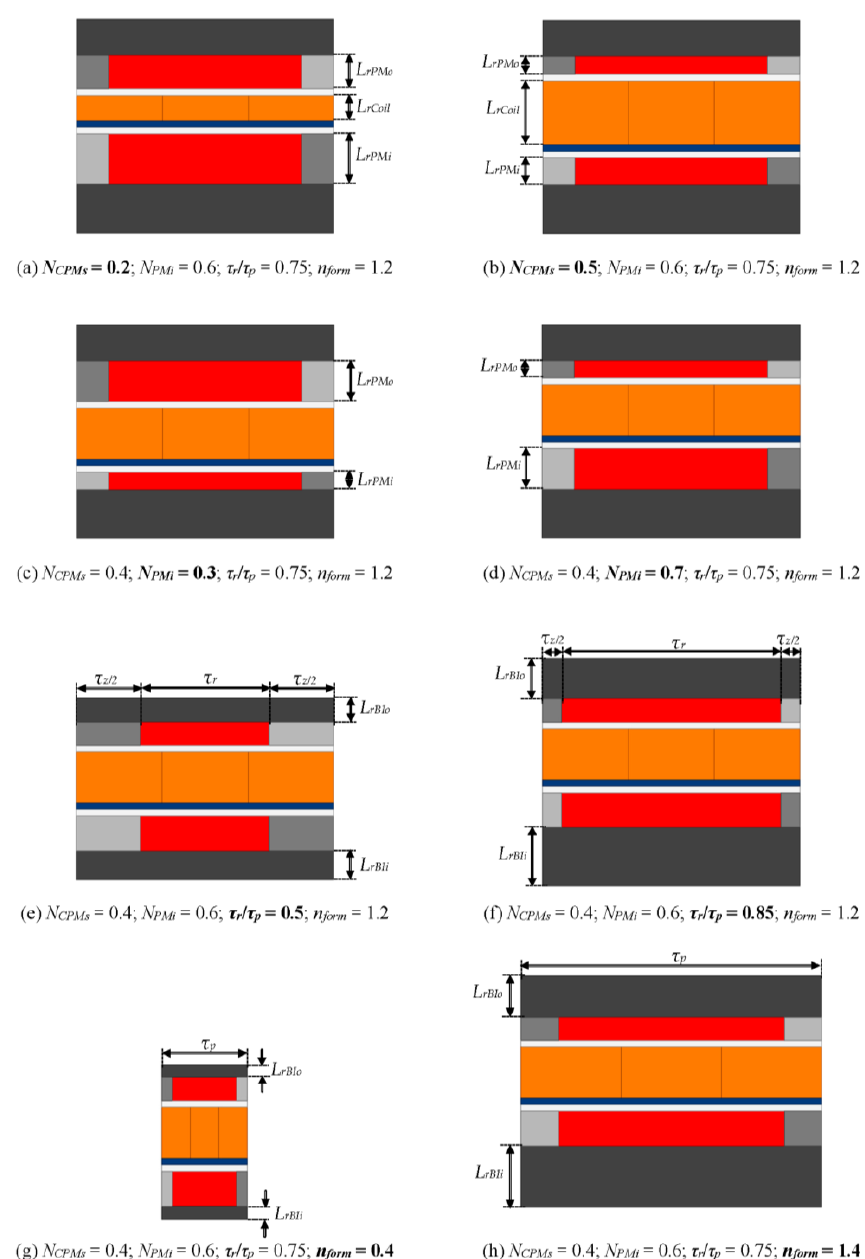
Figure 3. 2D parametric models of one pole pitch presenting limits of parametric variation according to Table 1: Variations ( a ) N CMPs = 0.2; ( b ) N CPMs = 0.5; ( c ) N PMi = 0.3; ( d ) N PMi = 0.7; ( e ) τ r / τ p = 0.5; ( f ) τ r / τ p = 0.85; ( g ) n form = 0.4; and ( h ) n form = 1.4. While one parametric variable was varied the others were kept